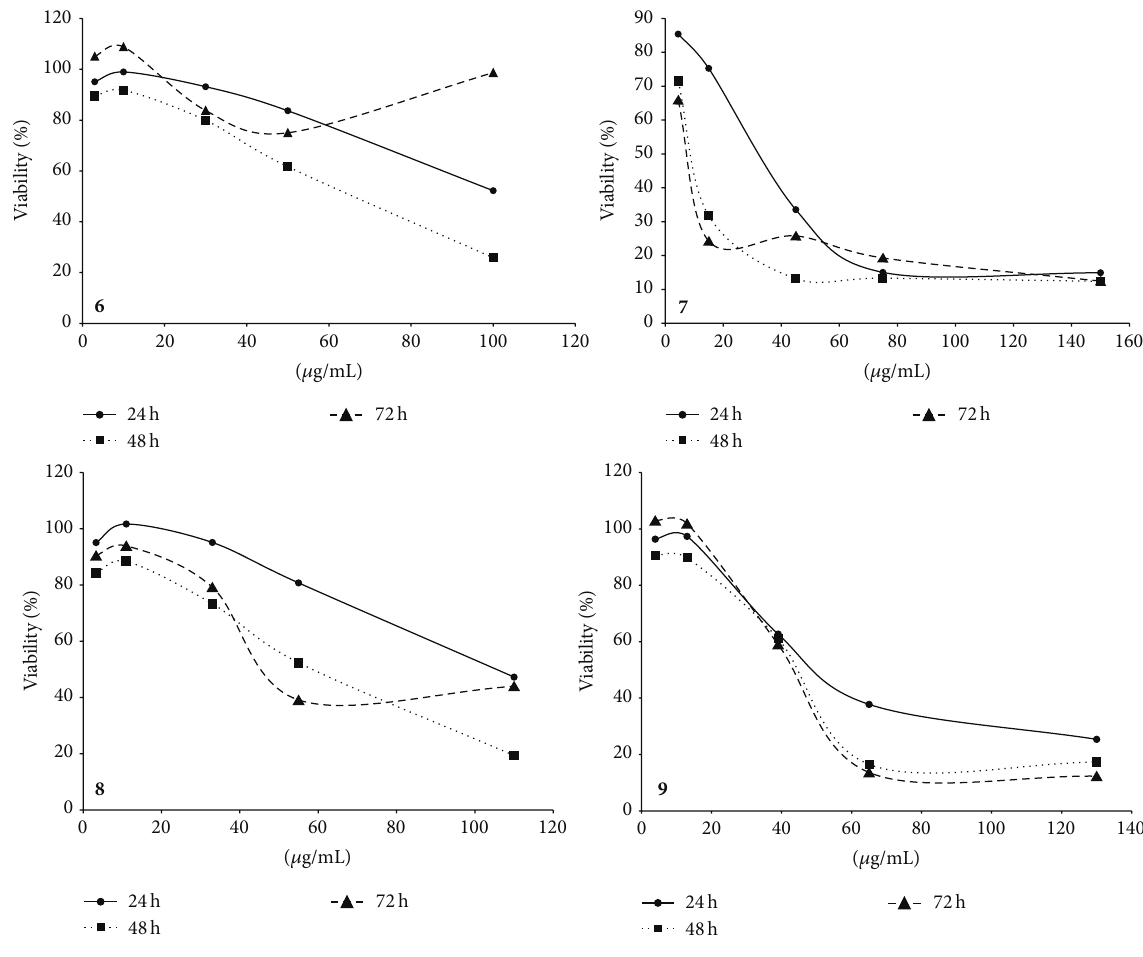
Figure 1: Dose-response graphs at 24, 48, and 72 h of 6 , 7 , 8 , and 9 .